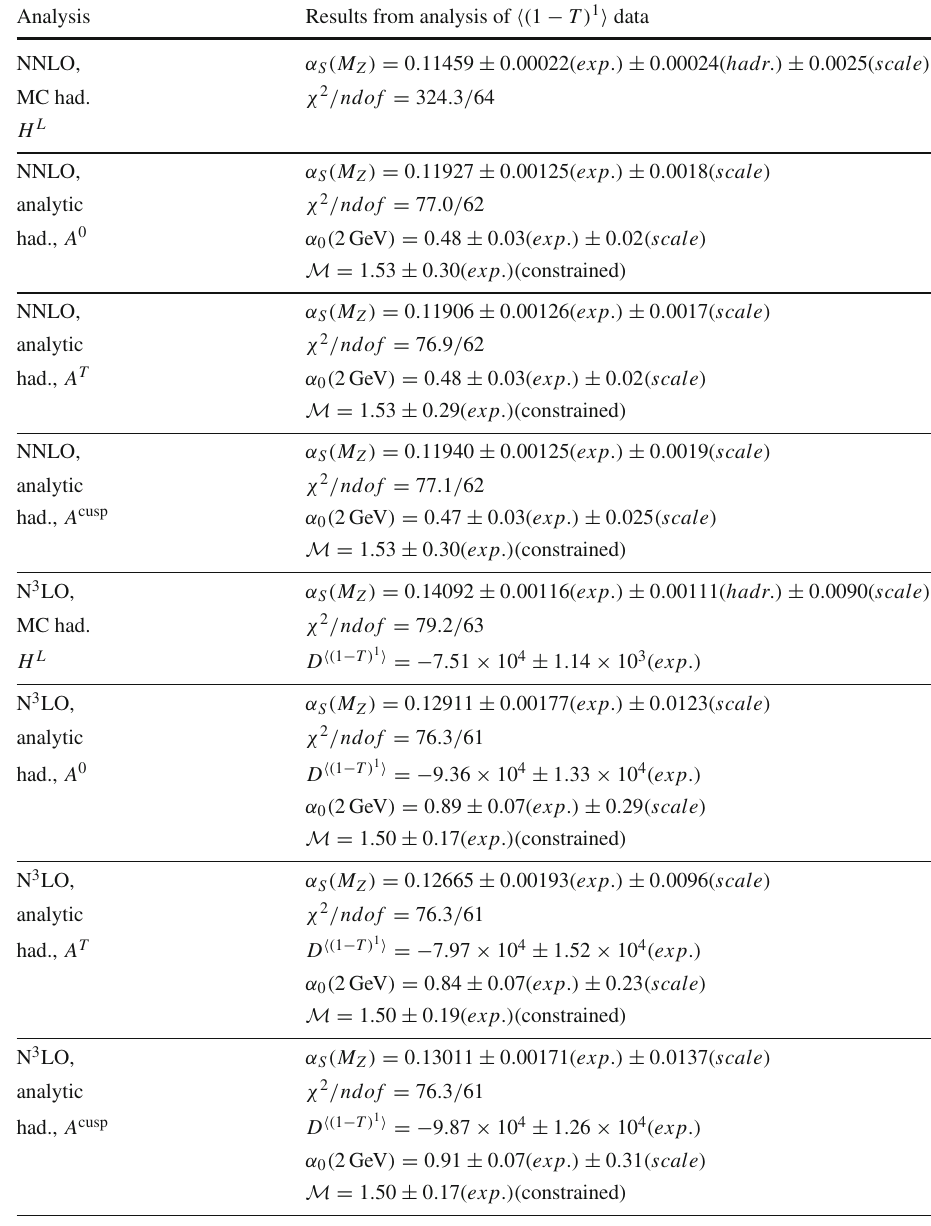
extraction analyses using the (cid:2) ( 1 − T ) 1 (cid:3) observable